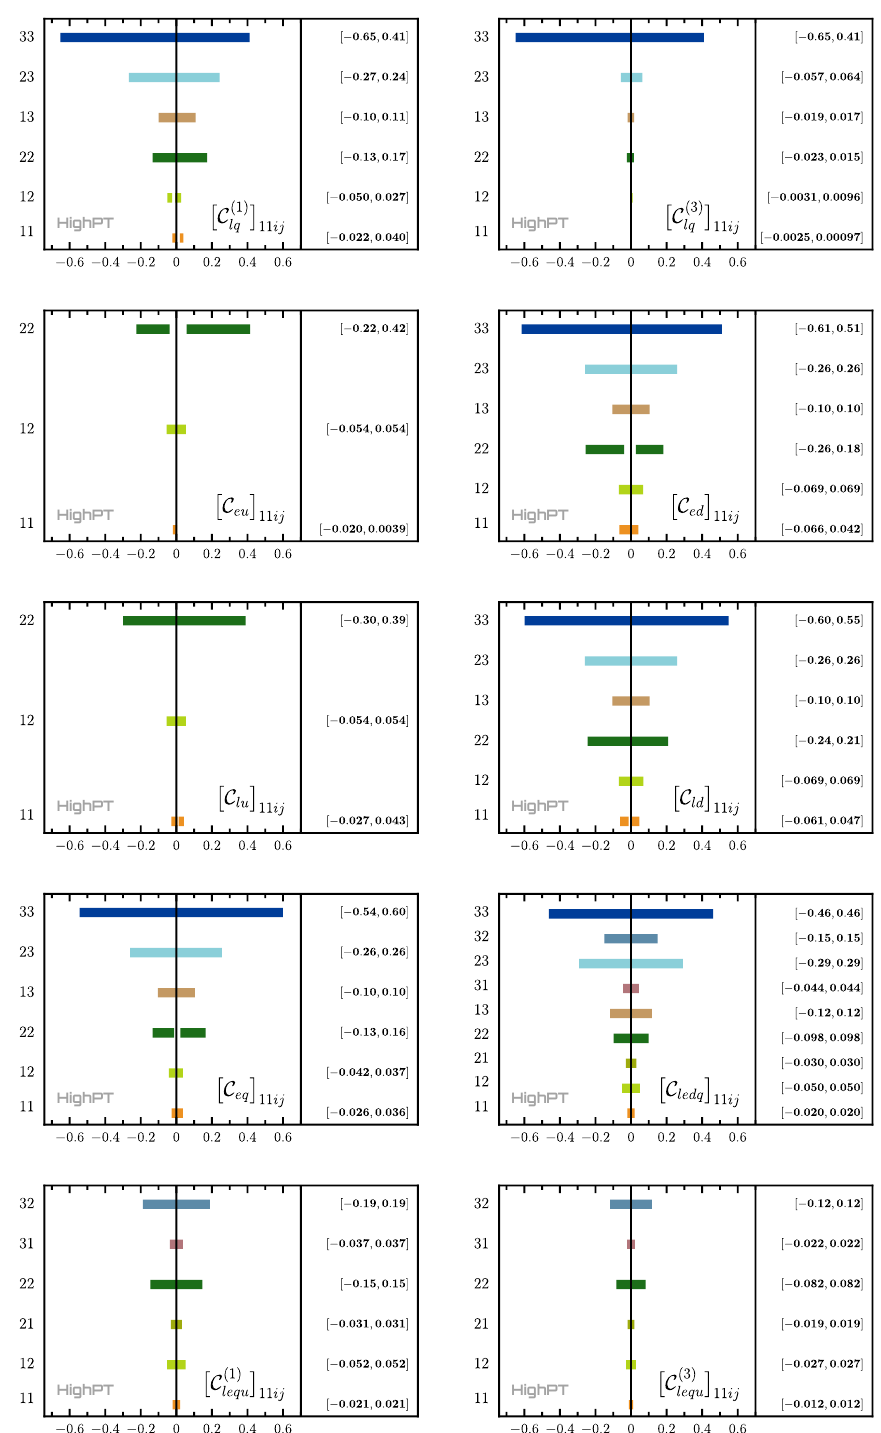
Figure 16. LHC constraints on semileptonic d = 6 Wilson coefficients with ee flavor indices to 95% CL accuracy, where a single coefficient is turned on at a time. See caption of figure 14. The largest deviation from the SM observed is ∼ 2 σ